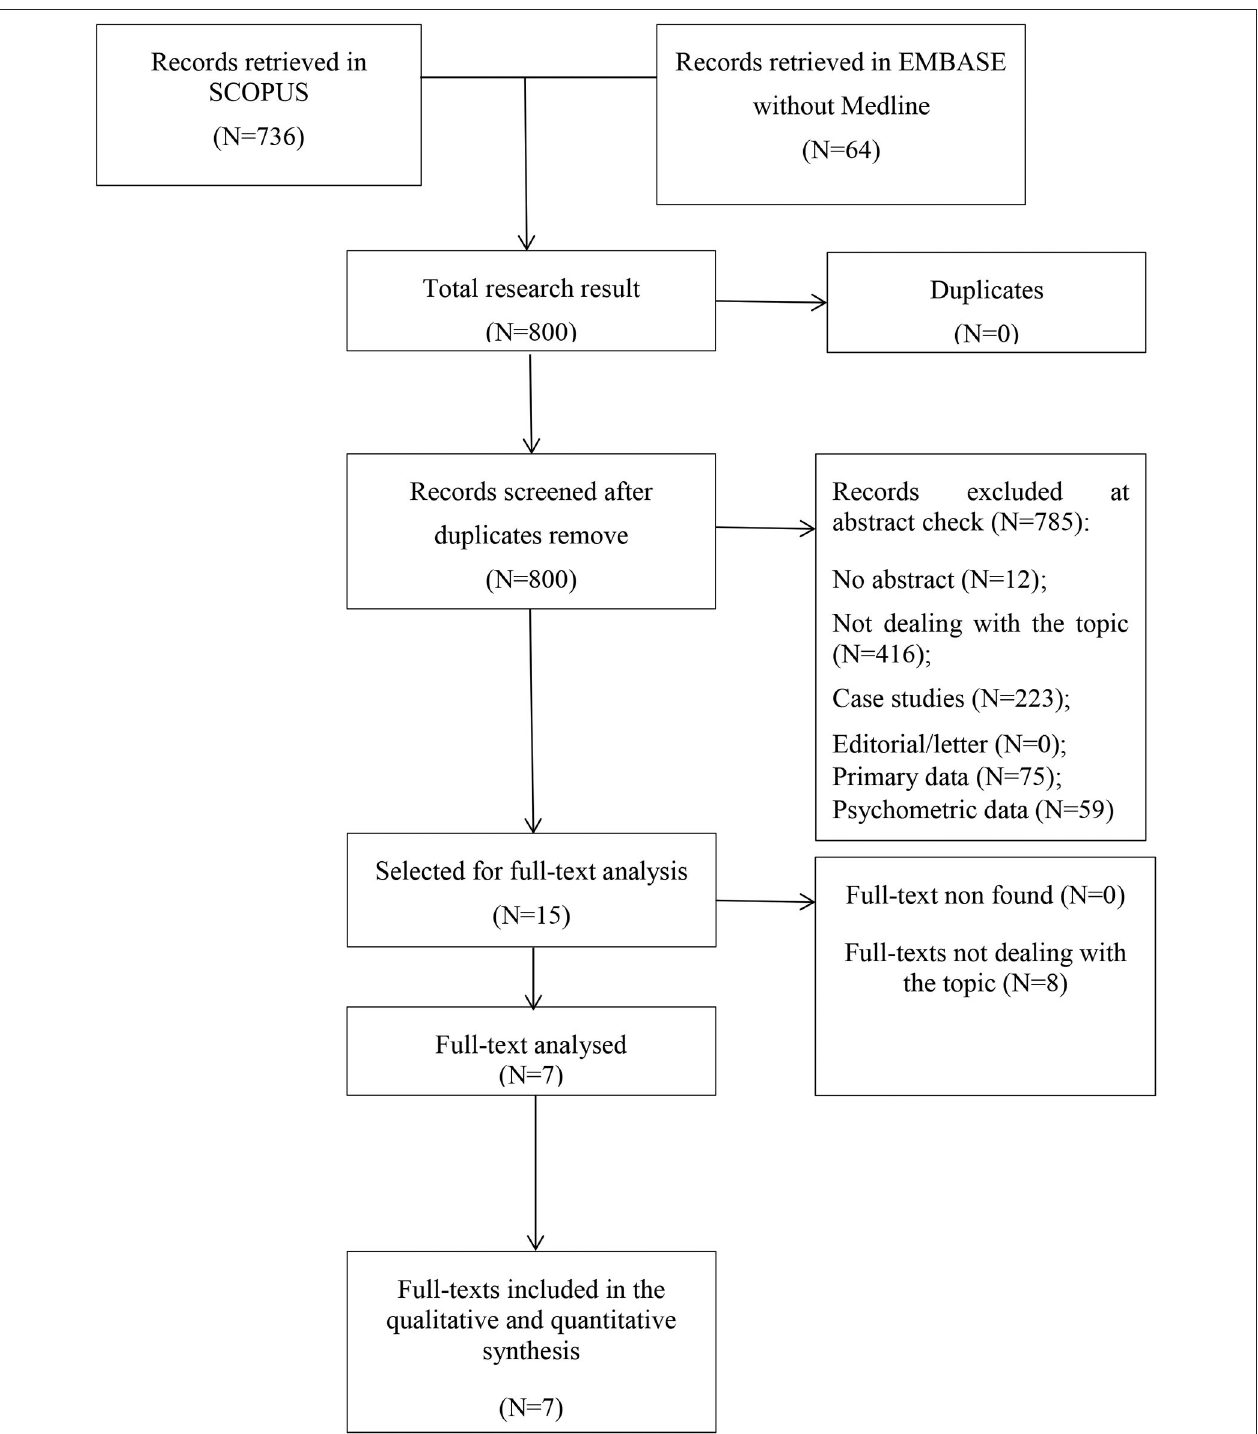
FIGURE 1 | Flowchart of papers’ selection.